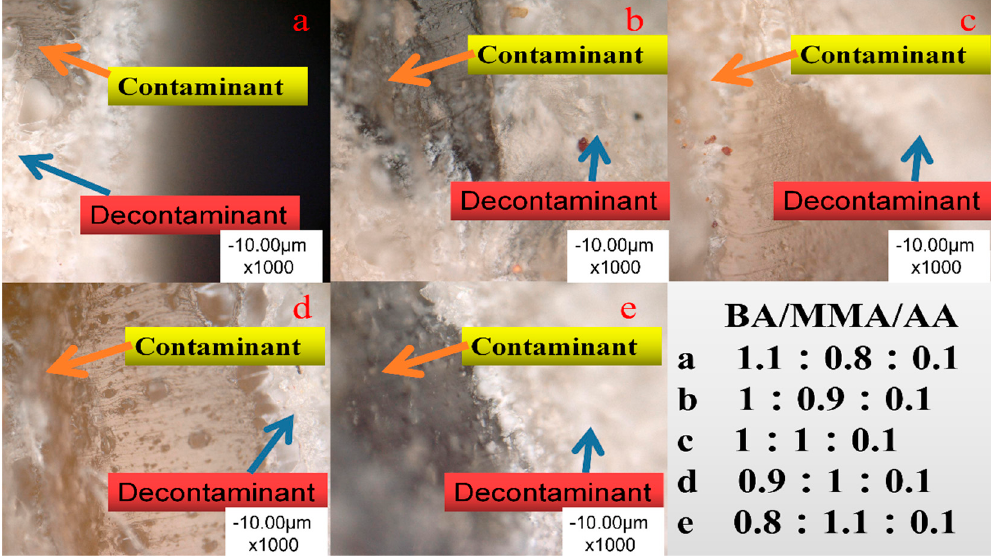
Figure 12. Action mechanism of decontaminant particles and pollutants.